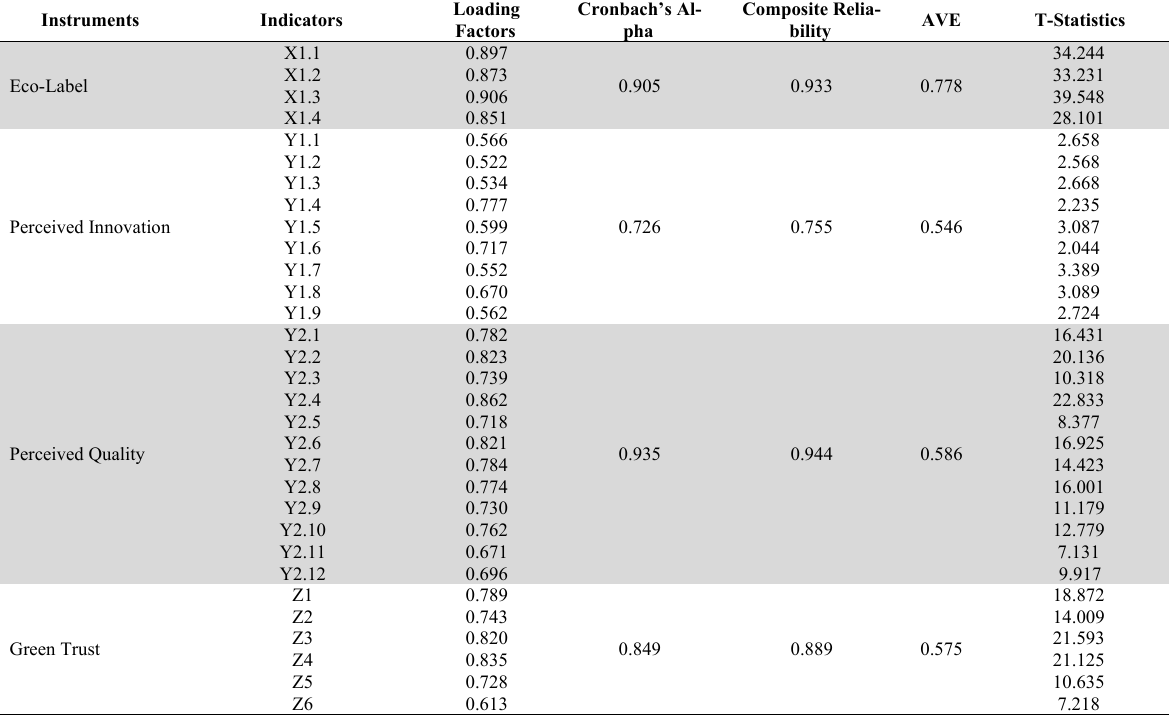
Inner and Outer Model